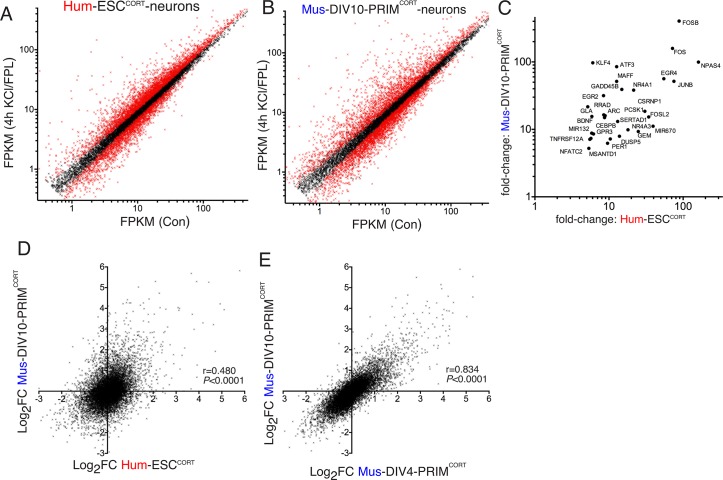
Conservation and divergence in gene regulation in neurons of human and mouse origin.(A,B) Analysis of gene expression changes induced by KCl/FPL in Hum-ESCCORT-neurons (A) and DIV10 Mus-PRIMCORT-neurons (B). Normalised RNA-seq read density (FPKM) mapping to each gene in RNA extracted from control vs. KCl/FPL-treated neurons is shown (n = 3 independent biological replicates). Genes whose expression was significantly altered by KCl/FPL treatment (Benjamini-Hochberg-adjusted p-value<0.05, calculated within DESeq2) are highlighted in red. (C) Cohort of human:mouse orthologous pairs where both are strongly (>5-fold) and significantly (Benjamini-Hochberg-adjusted p-value<0.05) induced in Hum-ESCCORT-neurons and DIV10 Mus-PRIMCORT-neurons respectively. (D) Correlation of KCl/FPL-induced fold-change in 11,302 ortholog pairs in DIV10 Mus-PRIMCORT-neurons vs. DIV10-Hum-ESCCORT-neurons. (E) Correlation of KCl/FPL-induced fold-change in the same 11,302 genes as in (D) in DIV10 vs. DIV4 Mus-PRIMCORT-neurons.DOI:
http://dx.doi.org/10.7554/eLife.20337.00310.7554/eLife.20337.004Figure 1—source data 1.Data set relating to Figure 1a–e.DOI:
http://dx.doi.org/10.7554/eLife.20337.00410.7554/eLife.20337.005Figure 1—source data 2.Data set relating to Figure 1—figure supplement 1a.DOI:
http://dx.doi.org/10.7554/eLife.20337.00510.7554/eLife.20337.006Figure 1—source data 3.Data set relating to Figure 1—figure supplement 1b.DOI:
http://dx.doi.org/10.7554/eLife.20337.00610.7554/eLife.20337.007Figure 1—source data 4.Data set relating to Figure 1—figure supplement 1c–d.DOI:
http://dx.doi.org/10.7554/eLife.20337.00710.7554/eLife.20337.008Figure 1—source data 5.Data set relating to Figure 1—figure supplement 1e–f.